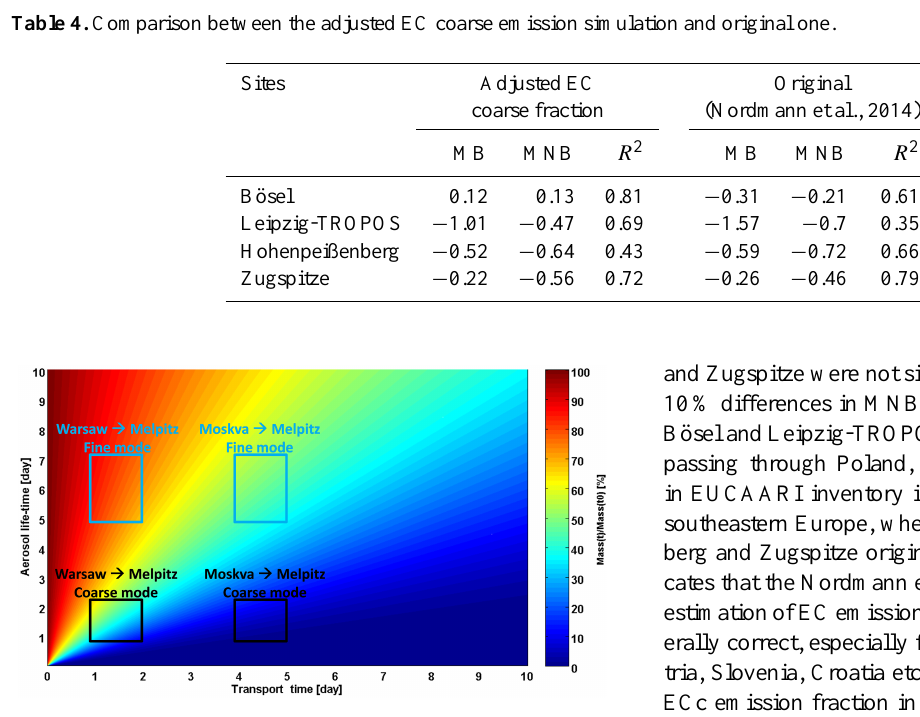
Figure 7. Aerosol mass residential rate with relationship of trans- port time and lifetime. The color indicates the percentage of aerosol mass that can be transported to